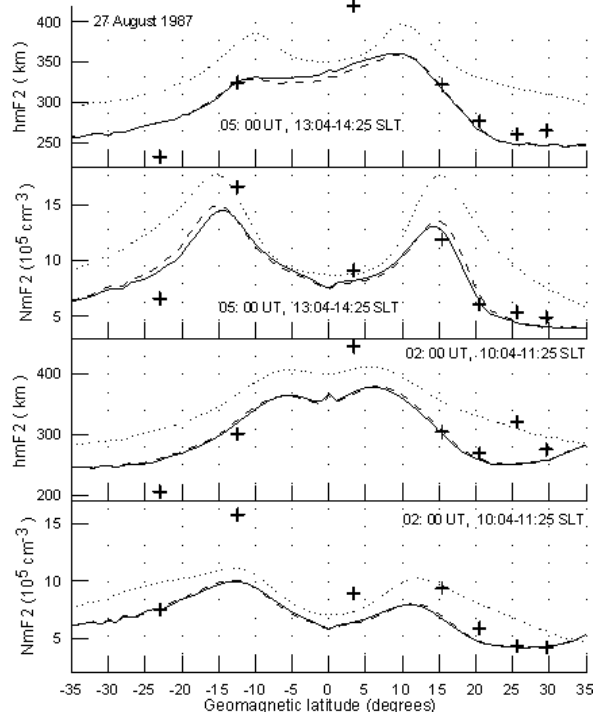
Fig. 15. Observed (crosses) and calculated (lines) hmF 2 and NmF 2 at 08:00 UT (two lower panels) and 11:00 UT (two upper panels) on 26 August 1987. The measured hmF 2 and NmF 2 are taken from the ionospheric sounder station listed in Table 1. The curves are the same as in Fig. 12.